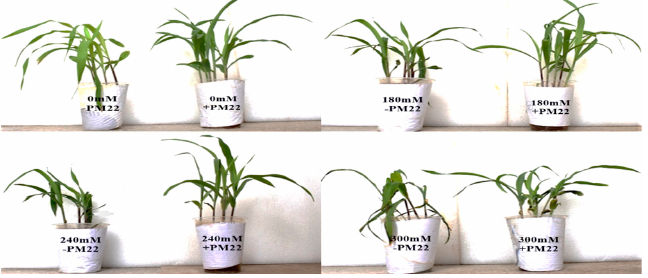
Figure 6. Effects of Bacillus safensis PM22 on the growth of maize under salinity stress.